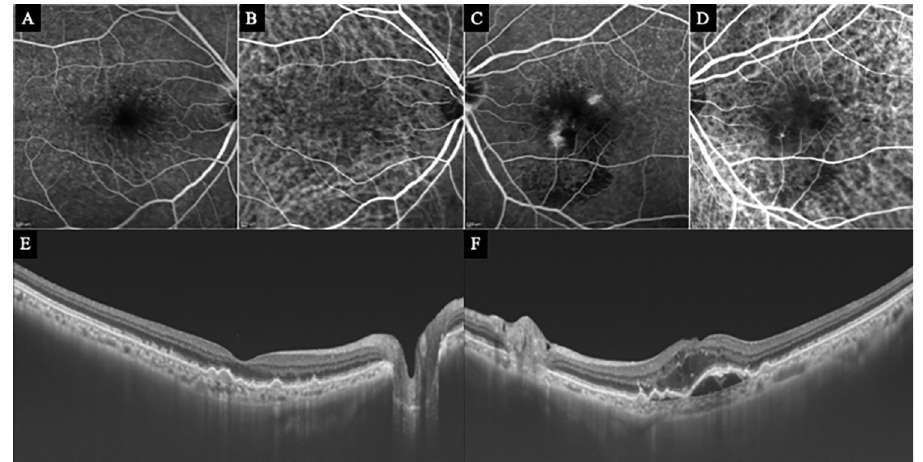
Fig 1. Fluorescein angiographic (FA), Indocyanine angiographic (ICGA), and optical coherence tomographic (OCT) images at the baseline of Case 3 with a type 3 macular neovascularization (MNV) in the left eye. Top row: FA and ICGA of the right eye (A and B) do not show any signs of an MNV. FA of left eye (C) shows leakage in the macula area. ICGA image of the left eye (D) shows hyperfluorescence corresponding to the leakage of FA. Bottom row: OCT image of the right (E) eye appears normal but the left (F) eye shows cystoid macular edema with pigment epithelial detachment (PED). The irregularities of the RPE are due to drusen.